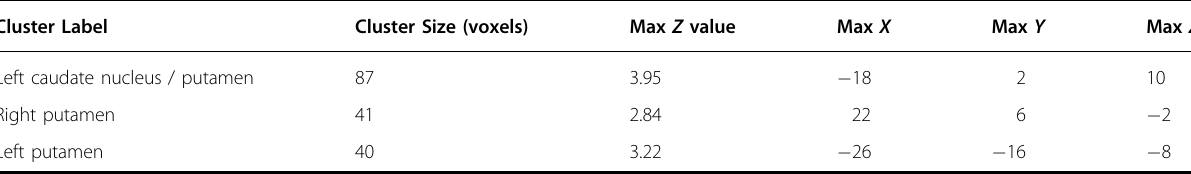
Table 2 Striatal clusters demonstrated ASD > control group differences for the contrast of (reward > neutral) BP ND values at the threshold of z > 2.3, re fl ecting greater difference in phasic DA release in the reward relative to the neutral condition in the control group relative to the ASD